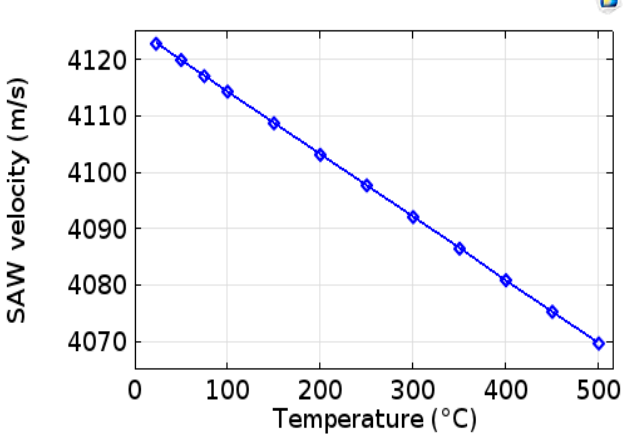
Figure 6. Variation in Rayleigh velocity as a function of temperature.